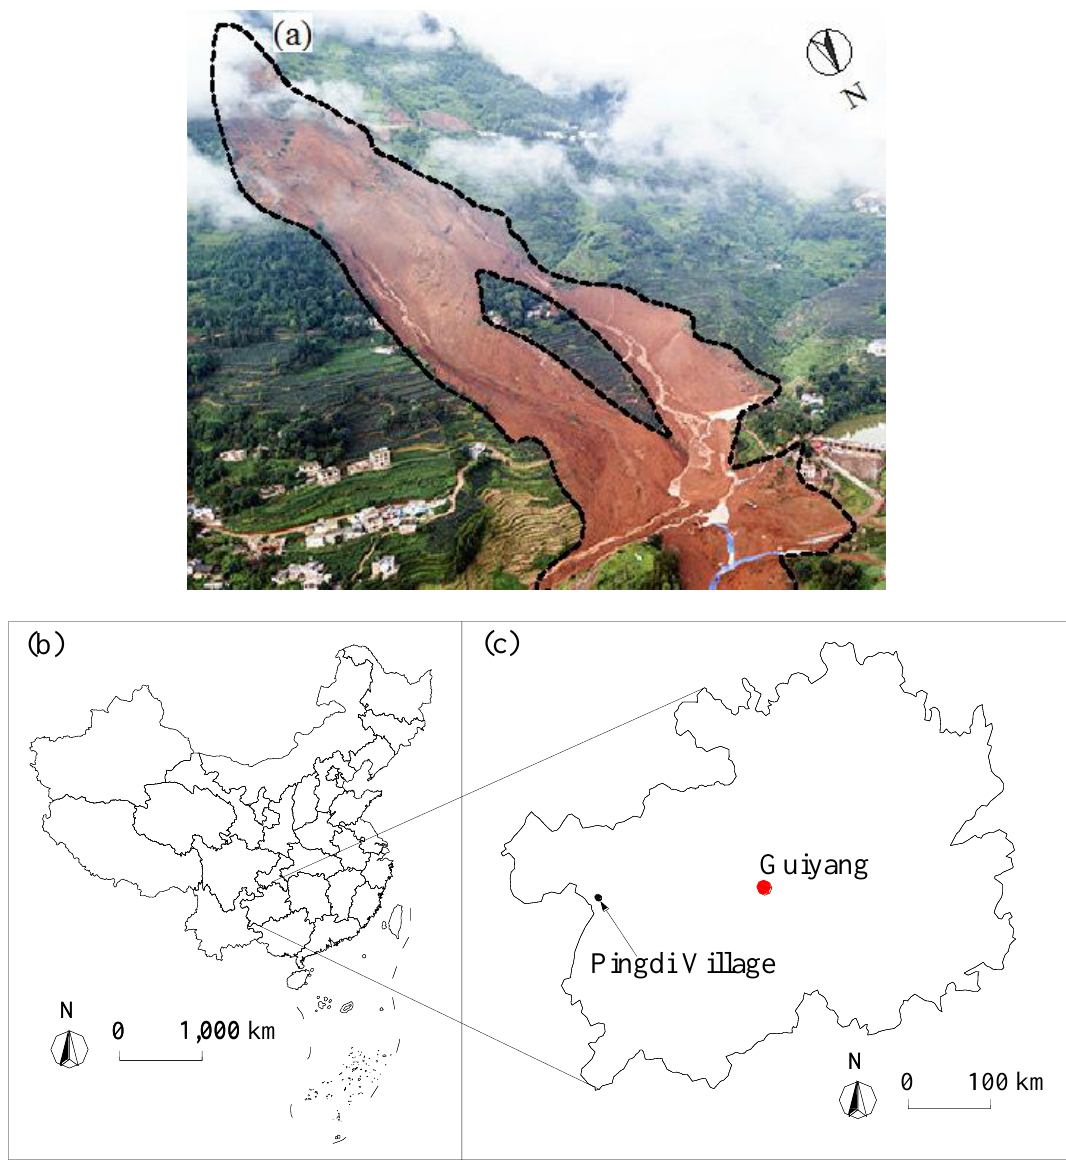
( a ) Pingdi village after the landslide (Source: http: // baijiahao.baidu.com / s?id = 1639927165371855884) ( b ) location of Guizhou, and ( c ) Location of Pingdi